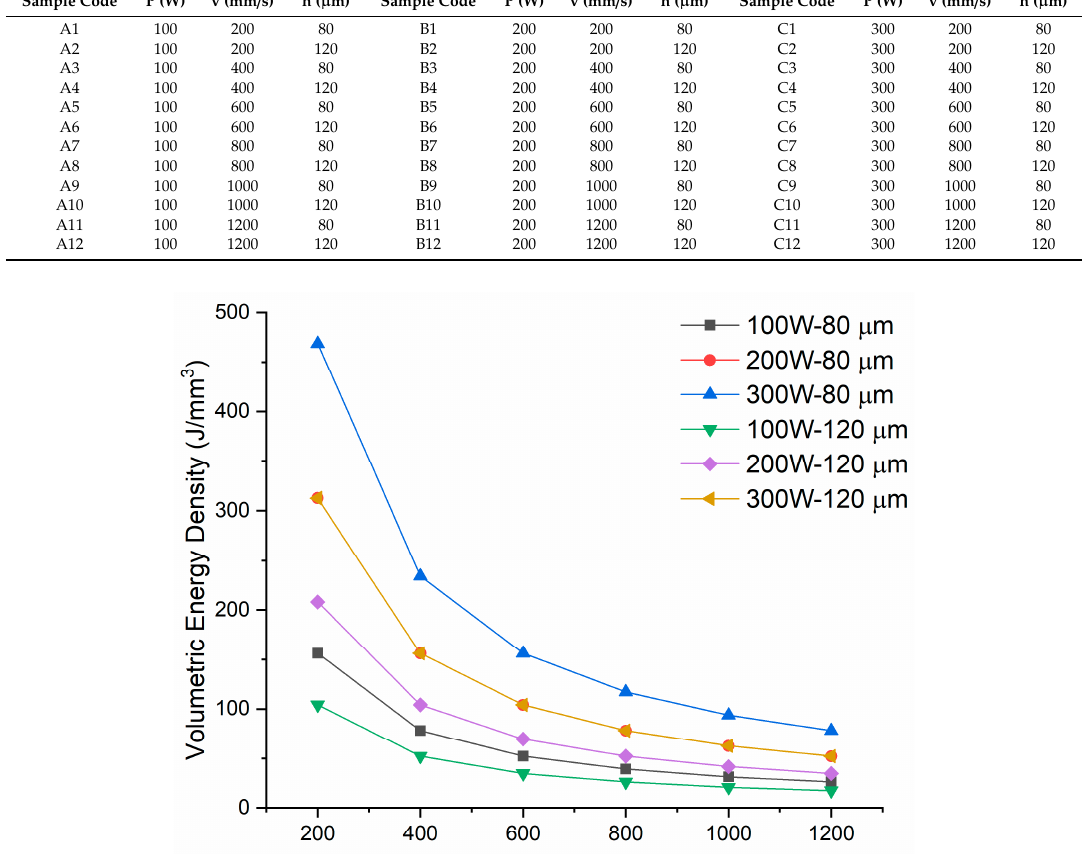
Table 3. Design of experiments implemented in this work.